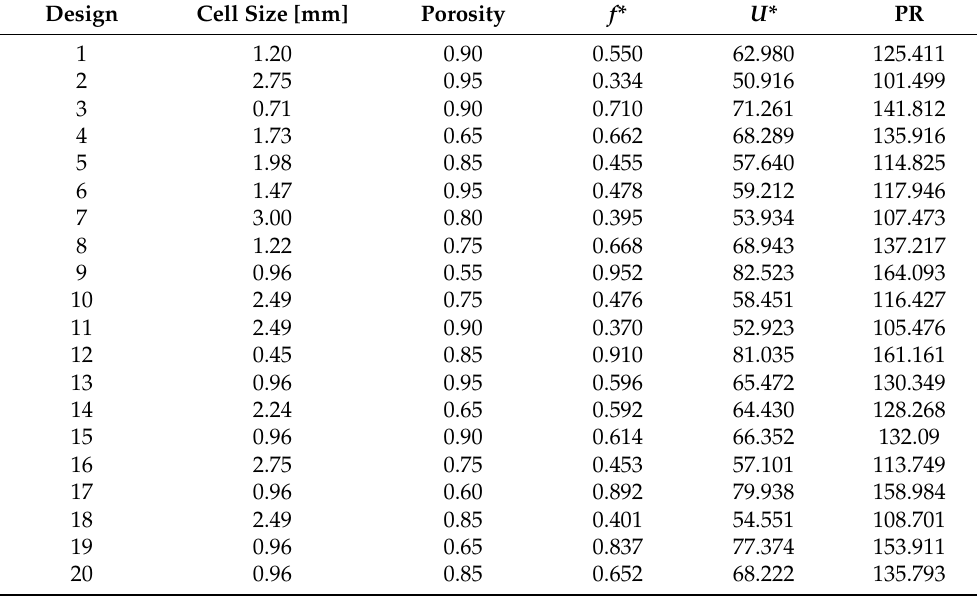
Table A1. Successful Design